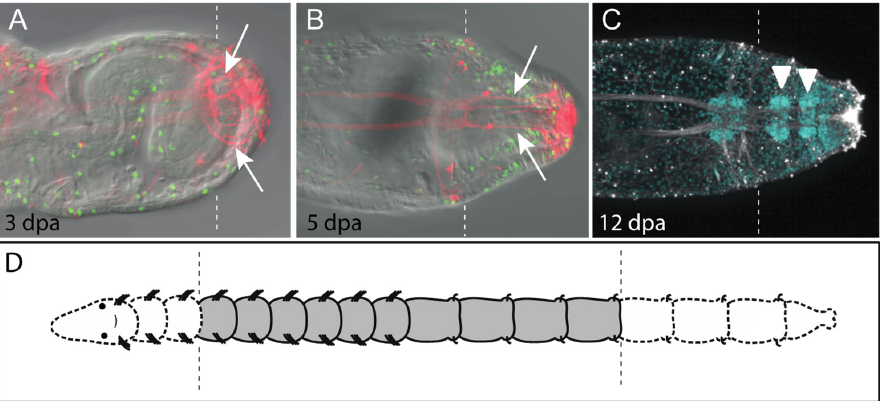
Figure 5. The central nervous system and regeneration. All panels are in ventral view with anterior to the left. Vertical dotted lines indicate approximate position of amputation site. ( A – C ) are confocal projections. Nerves are shown by acetylated tubulin reactivity (acet-tub+) in ( A – C ). ( A , B ) Arrows indicate extension of neurites (red) into the regenerating tissue. Green indicates incorporation of EdU. ( C ) Regeneration of posterior segments in the absence of brain and anterior segments. White arrowheads indicate regenerated ganglia. Nerves are indicated in white and nuclei in blue (Hoechst 33342 staining). ( D ) Scheme of double amputations to assess role of brain during posterior regeneration. Dotted areas show regions of body removed during amputation to generate image in C. Images are adapted from [38]. The time following amputation (in days) is indicated in bottom left of panel (dpa).